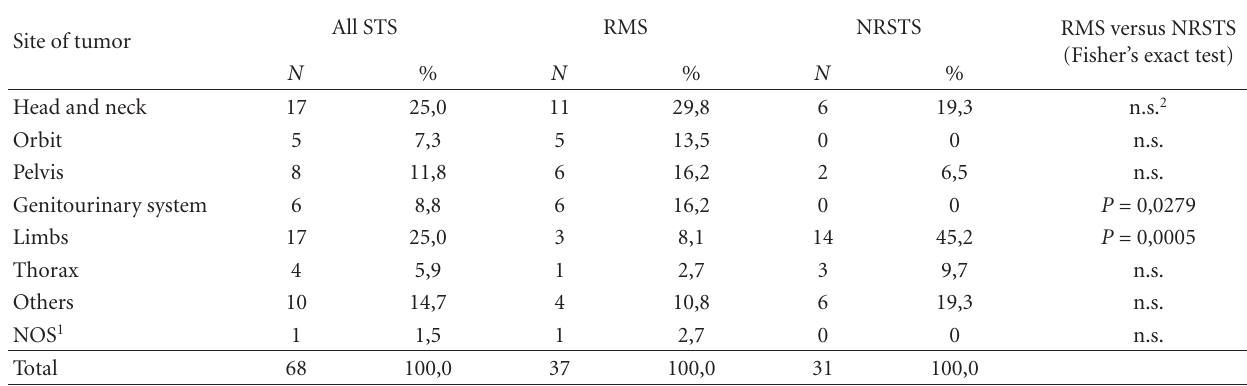
Table 3: Frequency and percentage of STS by site and